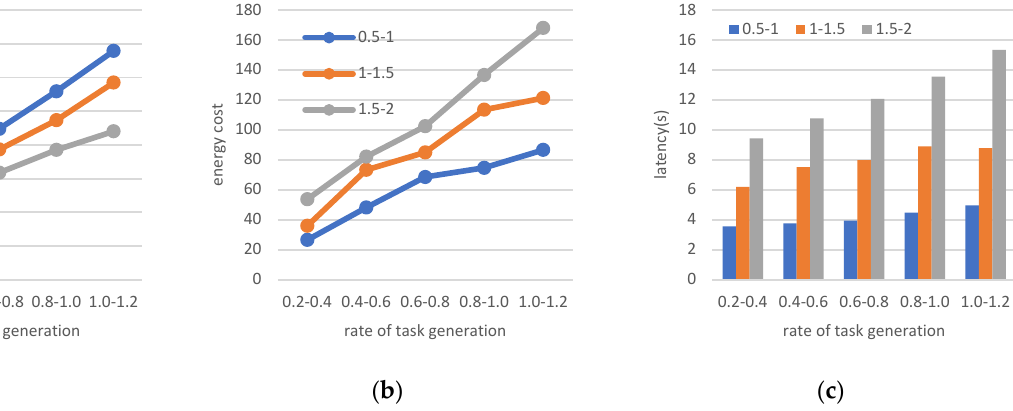
The initial values set for this experiment are n = 50, m = 25, C i = 960 cycles/byte, and C j = 10 GHz. We analyze the performance of the system when the frequency of terminal-generated tasks varies between 0.2/s and 1.2/s and the amount of task-generated data ranges are 0.5–1 MB, 1–1.5 MB, and 1.5–2 MB. The results are shown in Figure 9. Figure 8a. The increase in the number of terminals causes the number of processing tasks